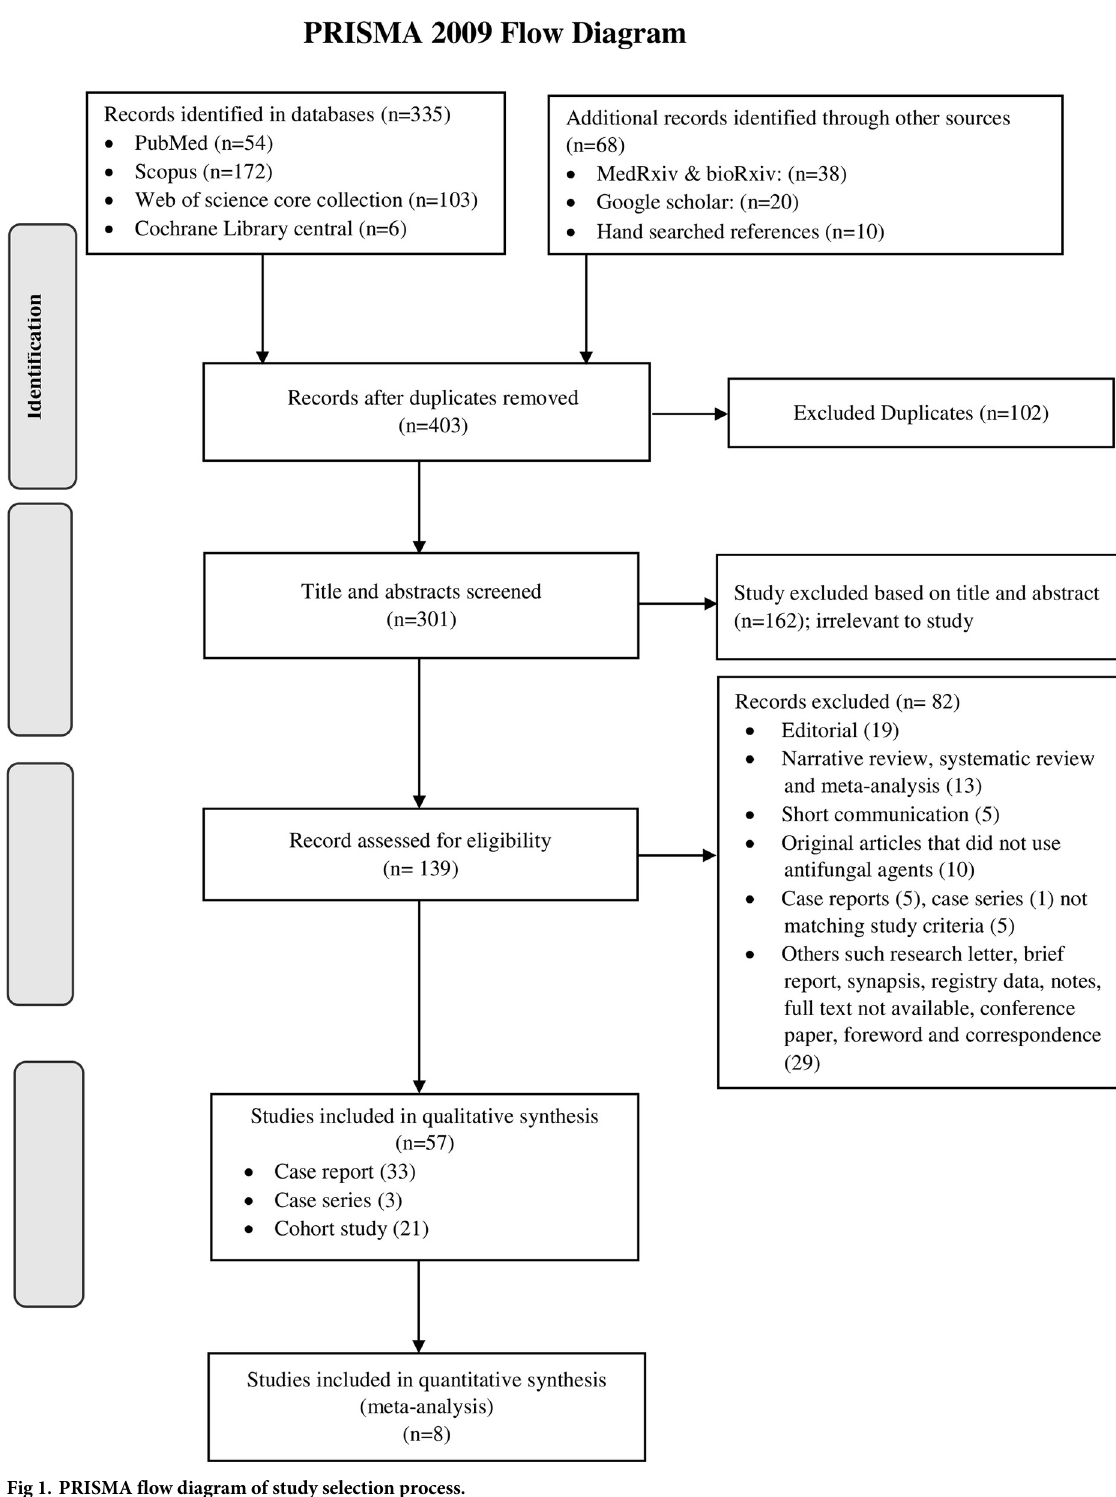
Fig 1. PRISMA flow diagram of study selection process.